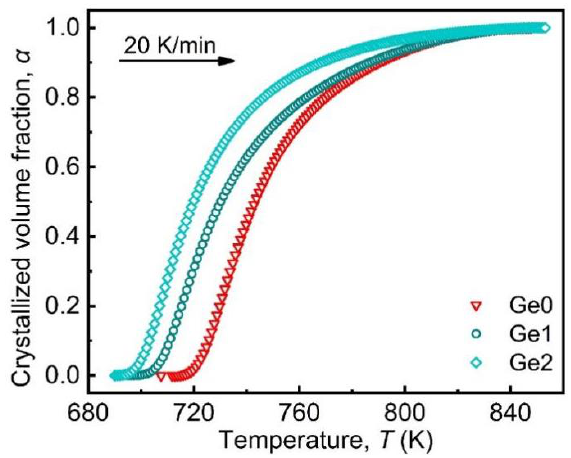
Figure 6. Curves of crystallization volume fraction versus temperature T for the first crystallization peak of the alloys ribbon at different heating rates.